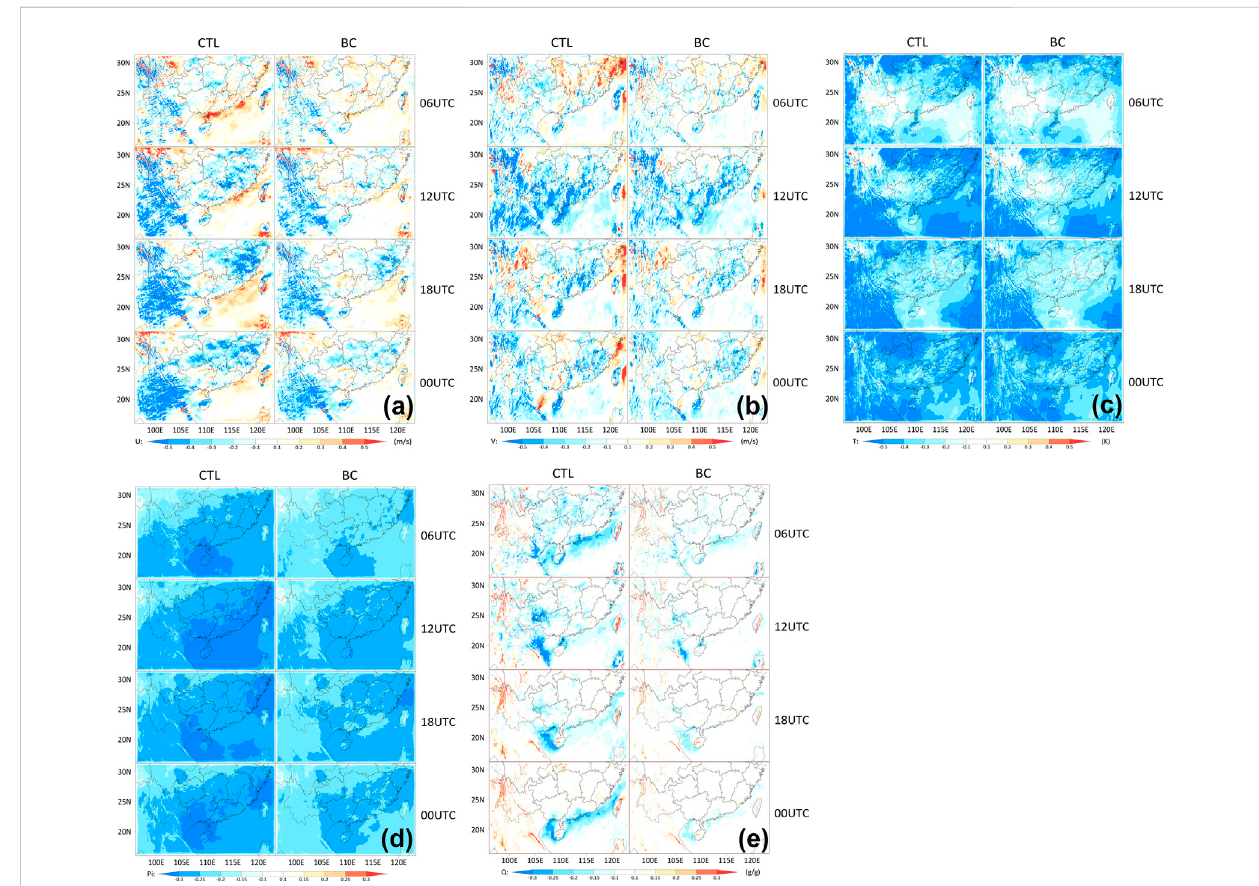
exchange on underlying surfaces, and this in fl uence will gradually decrease with increasing altitude. Figure 7 is the vertical pro fi le of the horizontal forecast mean bias and RMSE from June 1 to 15, 2022. First, the mean bias has an overall trend of large values in the lower and high model layers and small values in the middle model layers. Second, the vertical pro fi le of the four start times presents a different distribution, especially for the lower layer. For example, the vertical pro fi les of U and V show clear diurnal characteristics. It can also be found that the amplitude of the diurnal bias is large in the lower layer but small in the middle and high layers. On the other hand, the vertical pro fi le of the RMSE also presents a similar feature to that of mean bias. The results of the vertical pro fi le verify the previous results. The lower layer is easily affected by changes in the underlying surface, and the systematic diurnal bias is mainly present in the lower model layer. According to the above results, it can be found that the forecast mean bias and RMSE of CMA-MESO have some diurnal features.